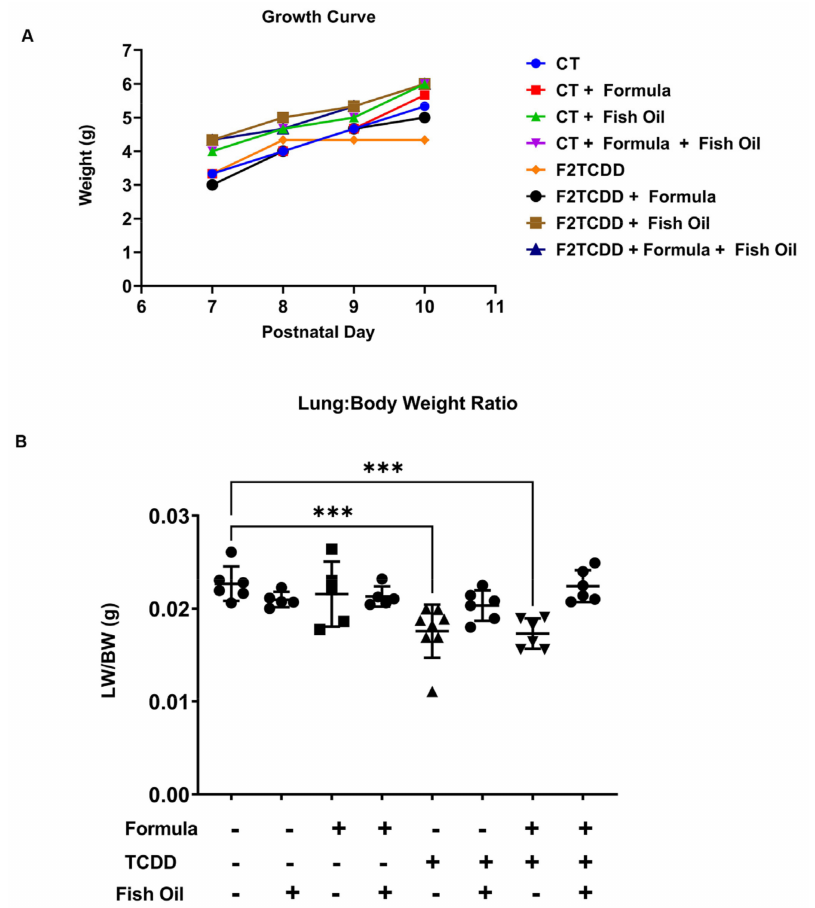
Figure 1. A dietary fish oil intervention improves postnatal development in pups: CT and F2TCDD pup body weight was monitored from postnatal day 7–10 ( A ), lung hypoplasia was determined by measuring lung-to-body weight ratios in CT and F2TCDD pups ( B ). Growth curve data represents the mean value of 4–5 non-littermate pups. Lung-to-body weight ratio data represents individual values of 4–5 non-littermate pups. Standard deviation is shown. *** p ≤